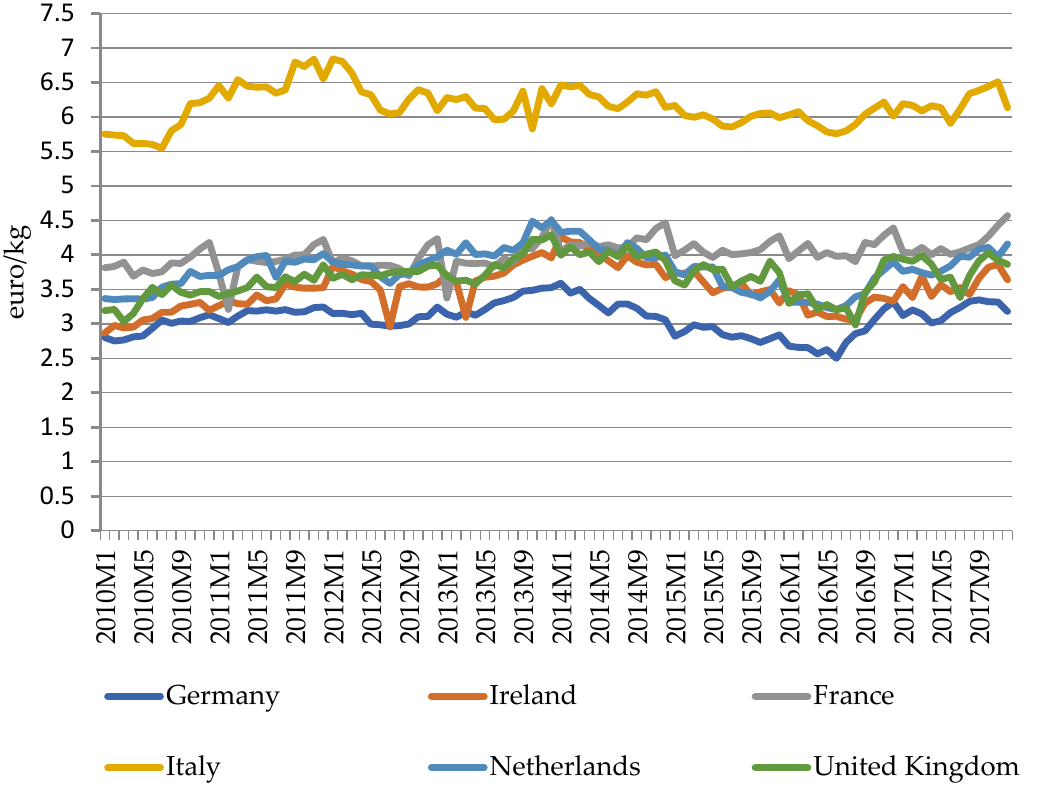
Figure 4. Extra-EU cheese export prices of major EU exporters, January 2010–December 2017. (Source: prices calculated by author using data downloaded from Eurostat Database, HS Classification EU trade since 1988 by HS2,4,6 and CN8 [DS-645593], product code: HS heading 0406–cheeses and curds, accessed in August 2019).